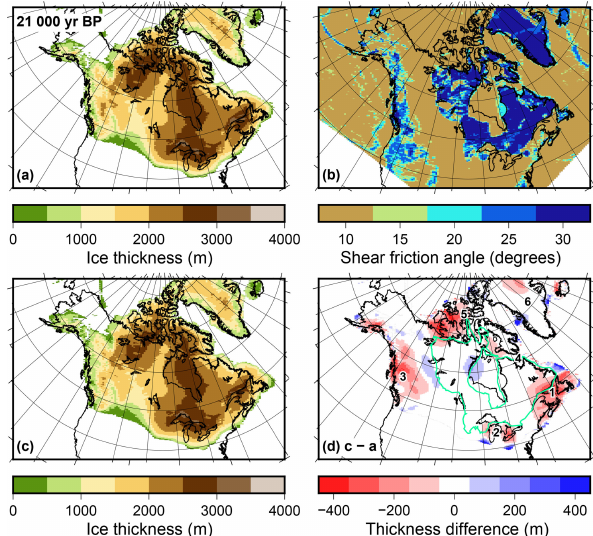
Figure 10. Impact of the geology on the simulation of North Amer- ican ice sheets. (a) Thickness of the ice sheets at 21000yrBP (after about 101000 years of simulation) with the default shear friction angle, φ = 30 ◦ . (b) Shear friction angle adjusted downwards sedi- ments and volcanic rock. (c) Ice thickness at 21000yrBP using the shear friction angle shown in (b) . (d) Difference in ice thickness between (a) and (c) . The numbers in (d) represent areas mentioned in the text: (1) eastern Canada, (2) Great Lakes, (3) Cordillera, (4) Hudson Strait, (5) Arctic Archipelago and (6) Greenland. The green outline shows the exposed limit of the Canadian